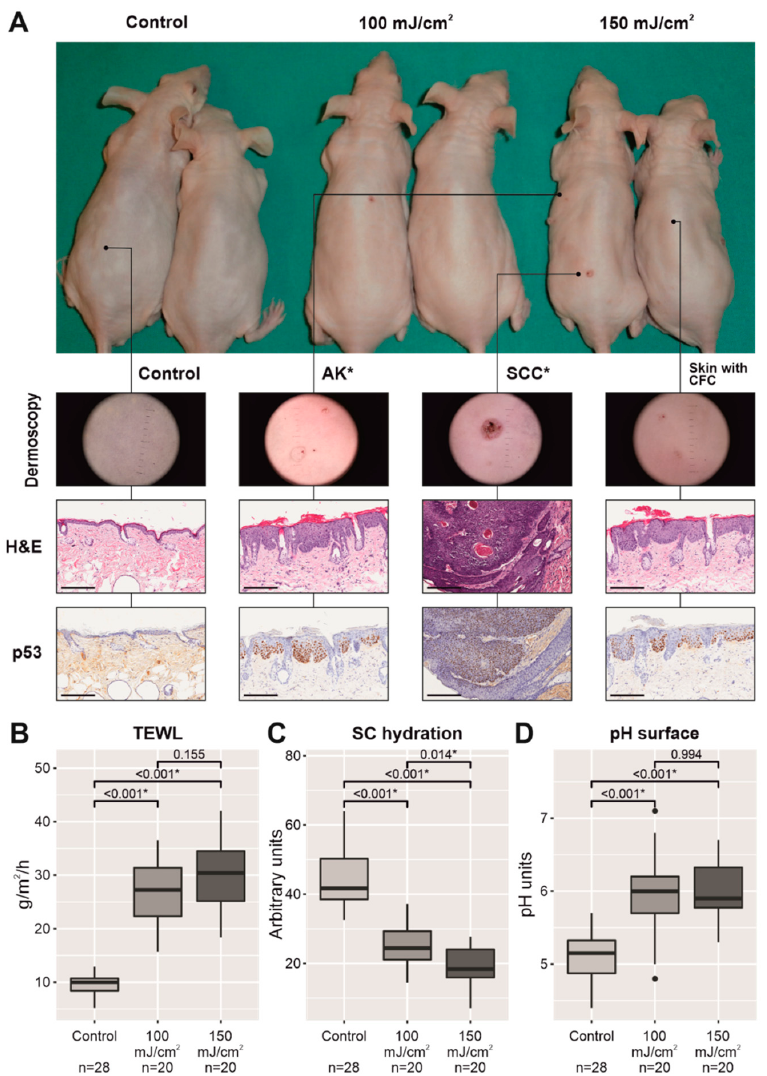
Figure 1. Skin appearance of two mice per group after UV-B irradiation, twice daily, 3 times per week, for 2 weeks, and then every day for another 12 weeks, from left to right: nonirradiated mice (control group), irradiated mice with 100 mJ/cm 2 (middle), and irradiated mice with 150 mJ/cm 2 (right). Macroscopic AKs and SCC, marked with an asterisk, were excluded from permeability, stratum corneum hydration, and surface pH measurements. The scale bar represents 200 µ m ( A ). Plots with the three physiological parameters linked to the permeability barrier in nonirradiated mice (control group) and UV-B-irradiated groups with CFC (excluding skin areas with macroscopic AKs and/or SCC): TEWL values ( B ), stratum corneum hydration ( C ), and surface pH ( D ). * p <